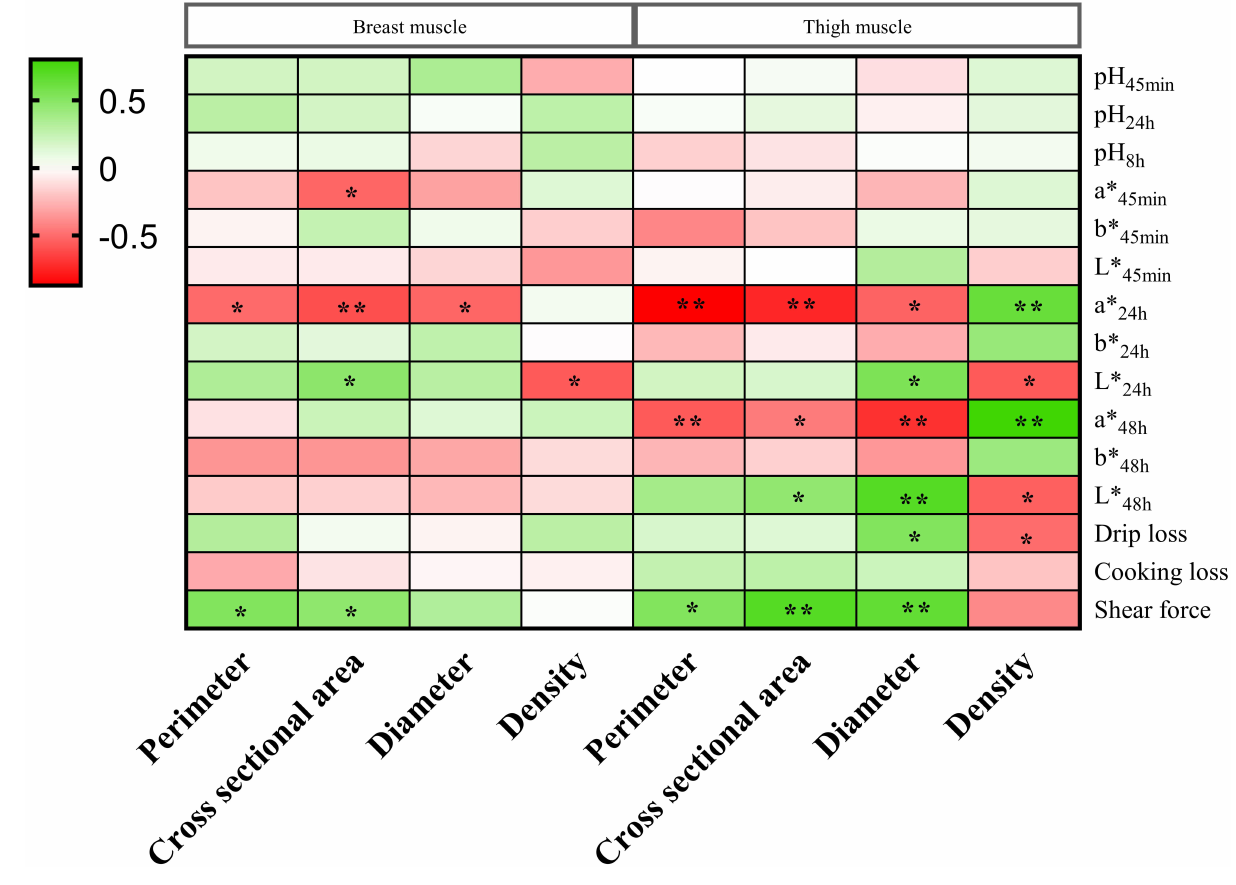
level of IGF-II compared with the S-Se + EM and Y-Se groups ( p <